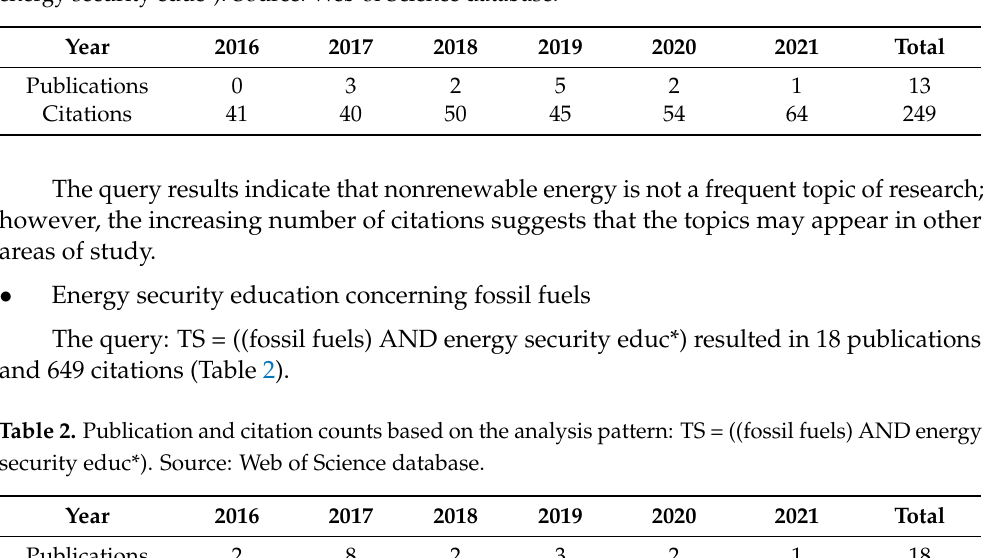
Table 1. Publication and citation counts based on the analysis pattern: TS = ((non renewable*) AND energy security educ*). Source: Web of Science database.